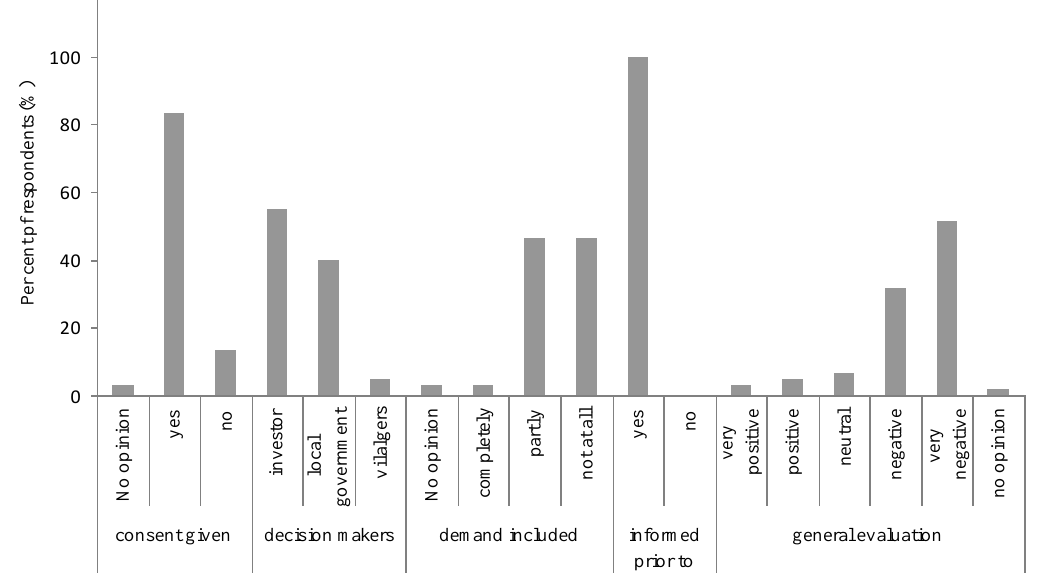
Figure 4. Respondents’ evaluation of compensation and resettlement process according to FPIC principle. Source: Authors’ household survey,